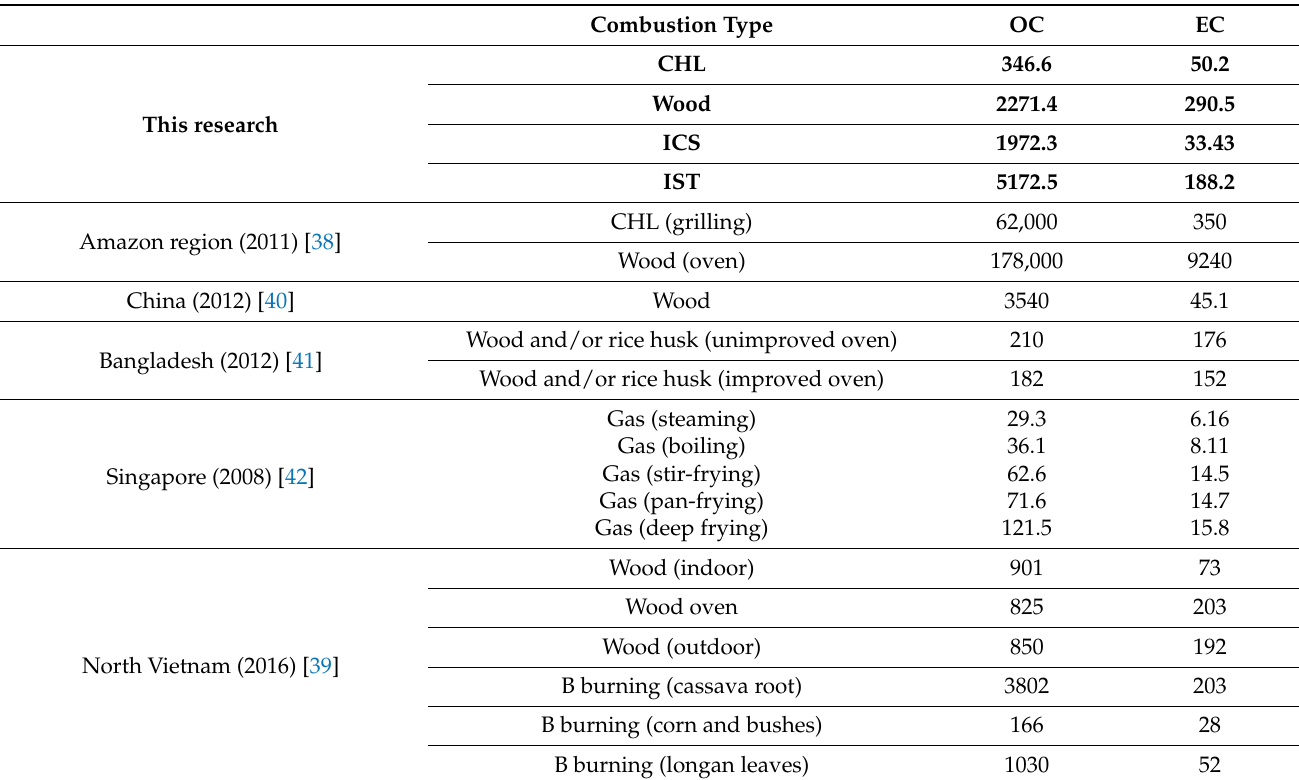
Table 1. Concentration of particulate matter constituents in this research (in bold) and